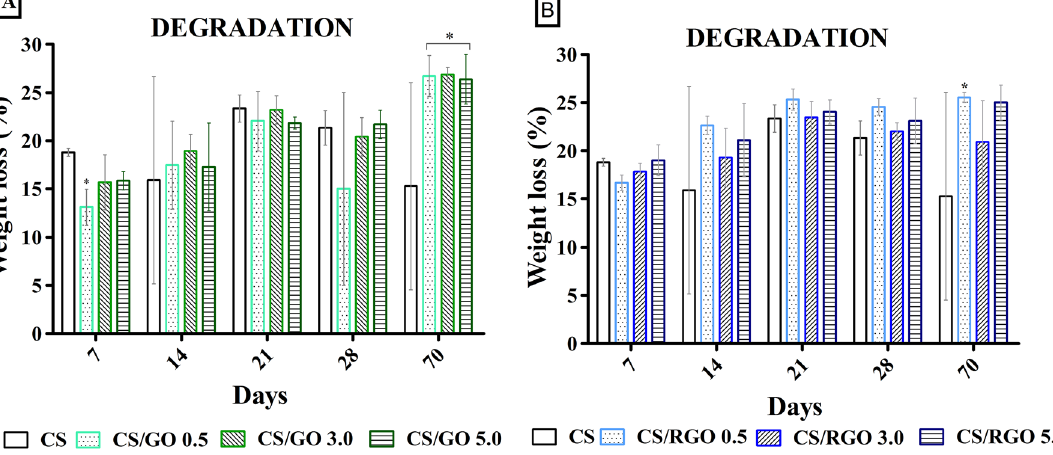
Figure 6. Comparative weight loss results with pristine CS membranes and CS membranes with graphene based fillers: CS/GO (A) and CS/RGO (B).